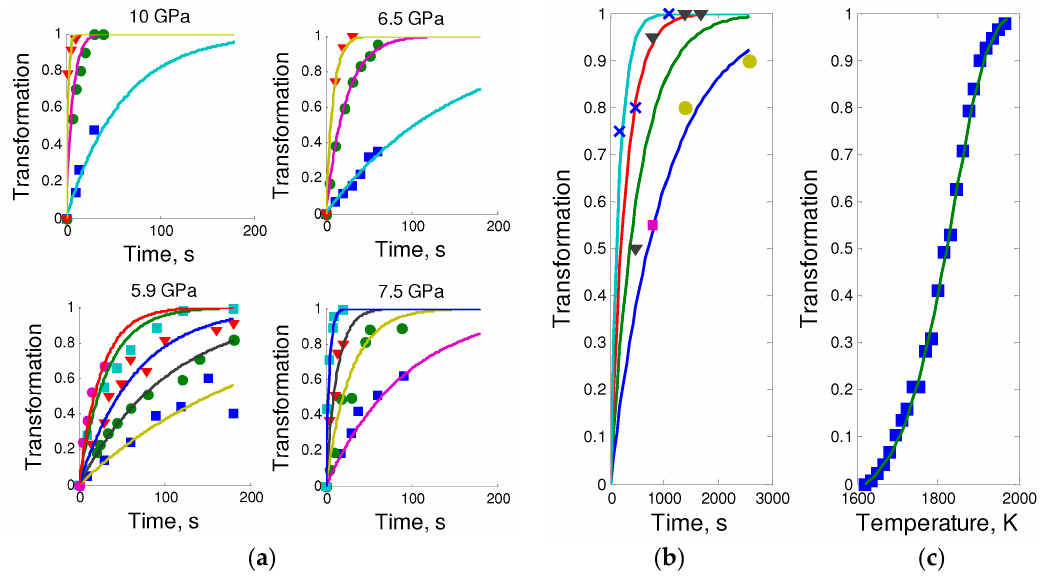
Figure 8 . Kinetic curves for hBN-to-cBN transformation (all theoretical curves calculated using Equations (5) and (6)): ( a ) Top: isothermal kinetic data from [83] for pure pyrolytic hBN; bottom: isothermal kinetic data from [84] for hBN of technical grade; ( b ) isothermal kinetic data from [67] for pure hBN; and ( c ) non-isothermal kinetic data (linear heating, heating rate β = 10 K/s) from our in situ observations for pure hBN obtained by thermally induced ordering of tBN.